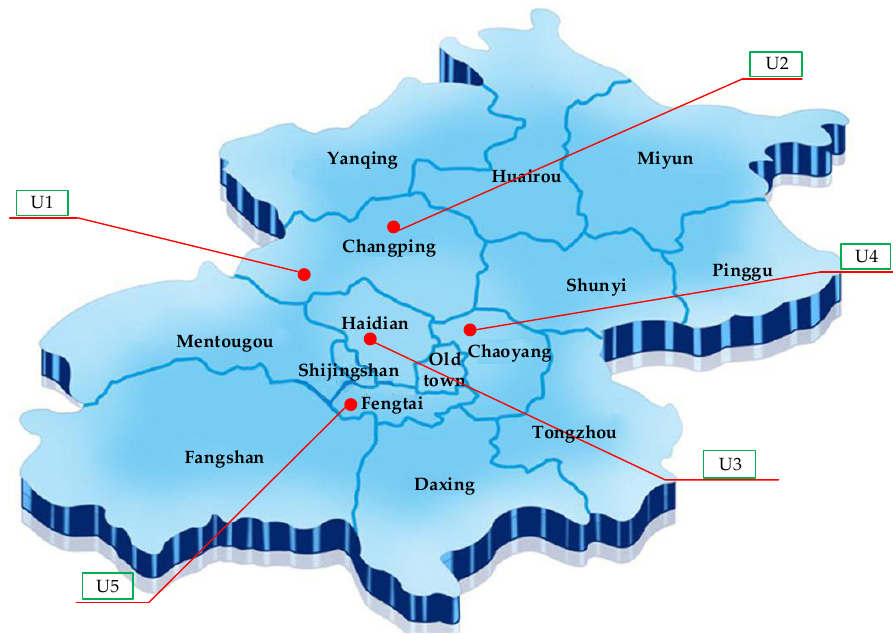
Figure 4. Location description of the selected alternatives in Beijing. Table 4. The key features of the five DR projects in residential areas.